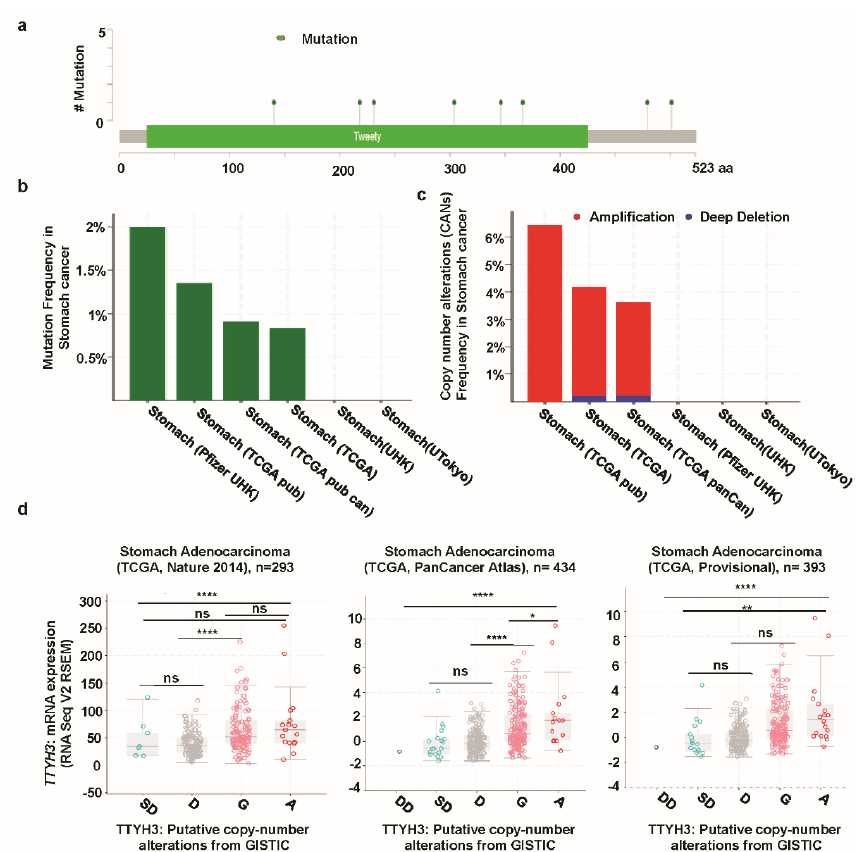
Figure 5. Mutation and copy number alterations in TTYH3 in GC / SC determined using cBioPortal (http: // www.cbioportal.org): ( a ) Alteration of a total of eight mutation spots was detected between amino acids 0 and 523 of the TTYH3 protein. The lollipop plots show the type and location of mutations. ( b ) TTYH3 mutation frequencies in GC / SC was presented as bar diagram. ( c ) Frequency of genomic alterations in TTYH3 in GC / SC was presented as bar diagram. ( d ) The graph depicts the correlation between TTYH3 expression and copy number alterations in GC / SC of TCGA data. Abbreviations represent the types of copy number alterations: deep deletions (DD), shallow deletion (SD), diploid (D), gain (G), and amplification (A). (* p < 0.05; **** p < 0.0001; ns , not significant)